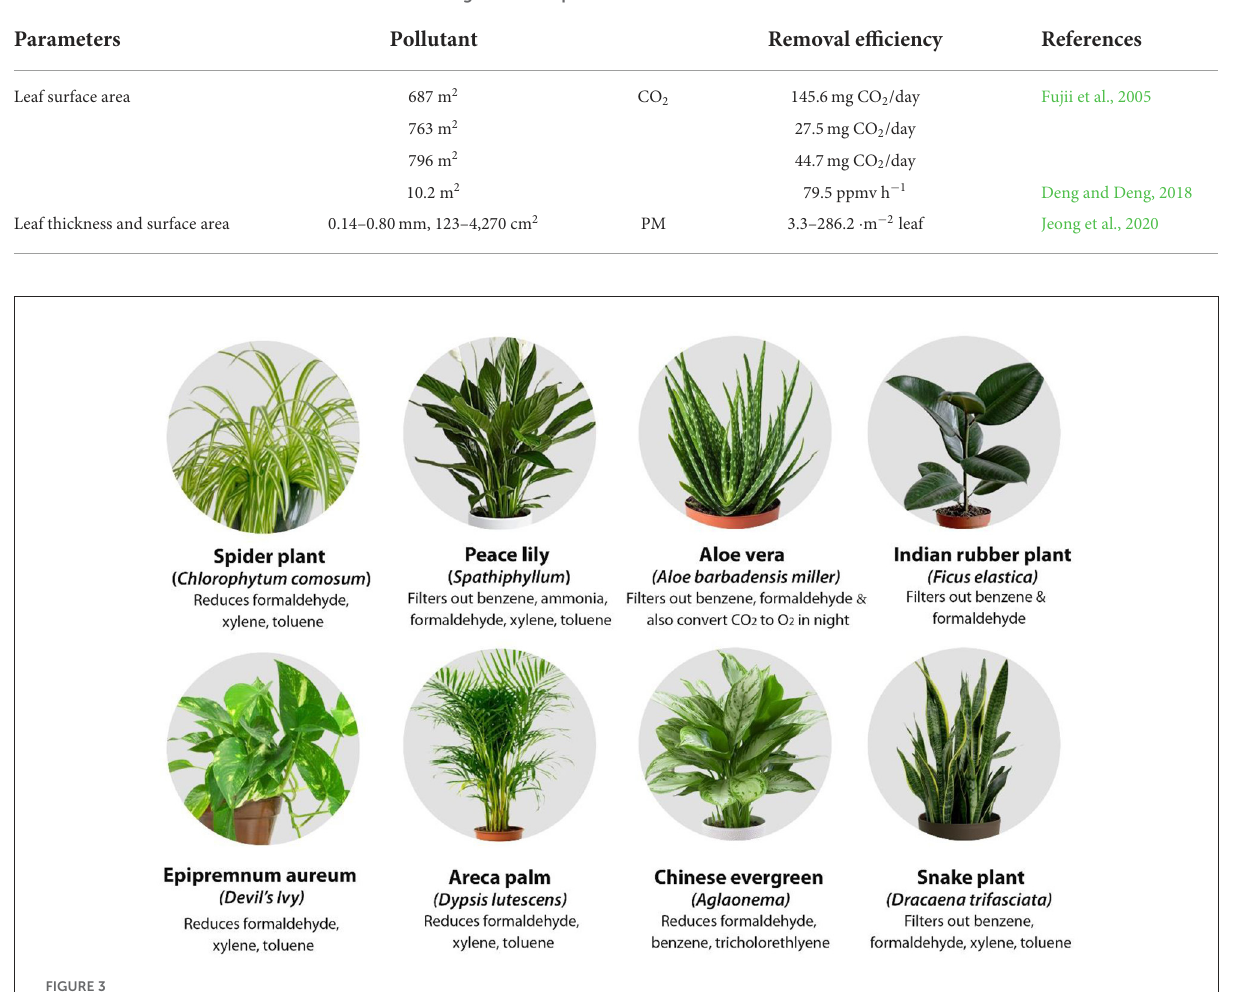
FIGURE3 List of selected air-purifying house